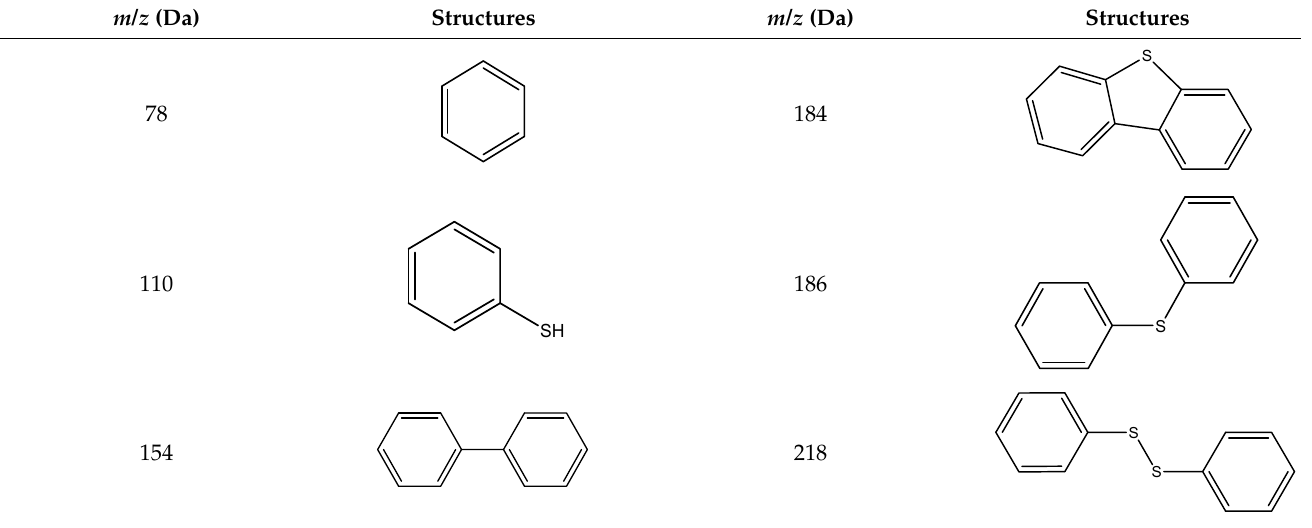
Table 1. Structures of detectable products found in the TGA-MS and GC analyses. m / z (Da) Structures